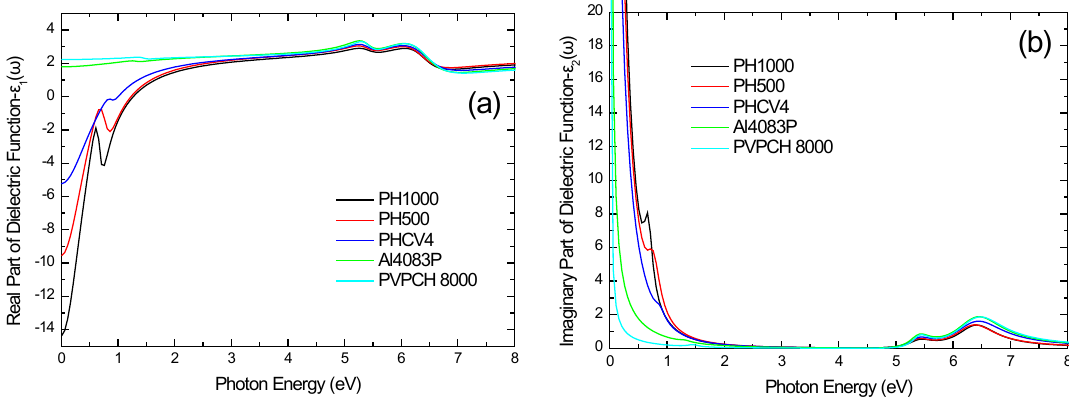
Figure 3. ( a ) Real and ( b ) imaginary parts of the calculated bulk dielectric function of the different PEDOT:PSS formulations in the IR–UV spectral region.